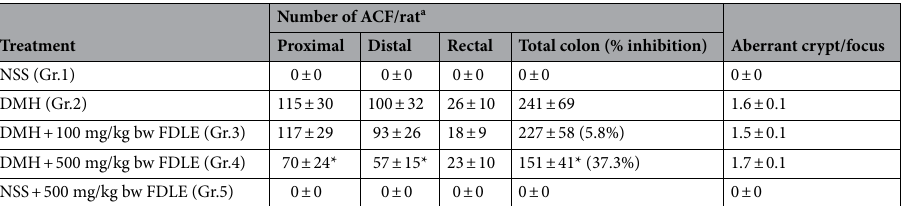
Figure 2. The experimental protocol and treatment schedule. ( a ) Initiation stage and ( b ) post-initiation stage of DMH-induced ACF formation.